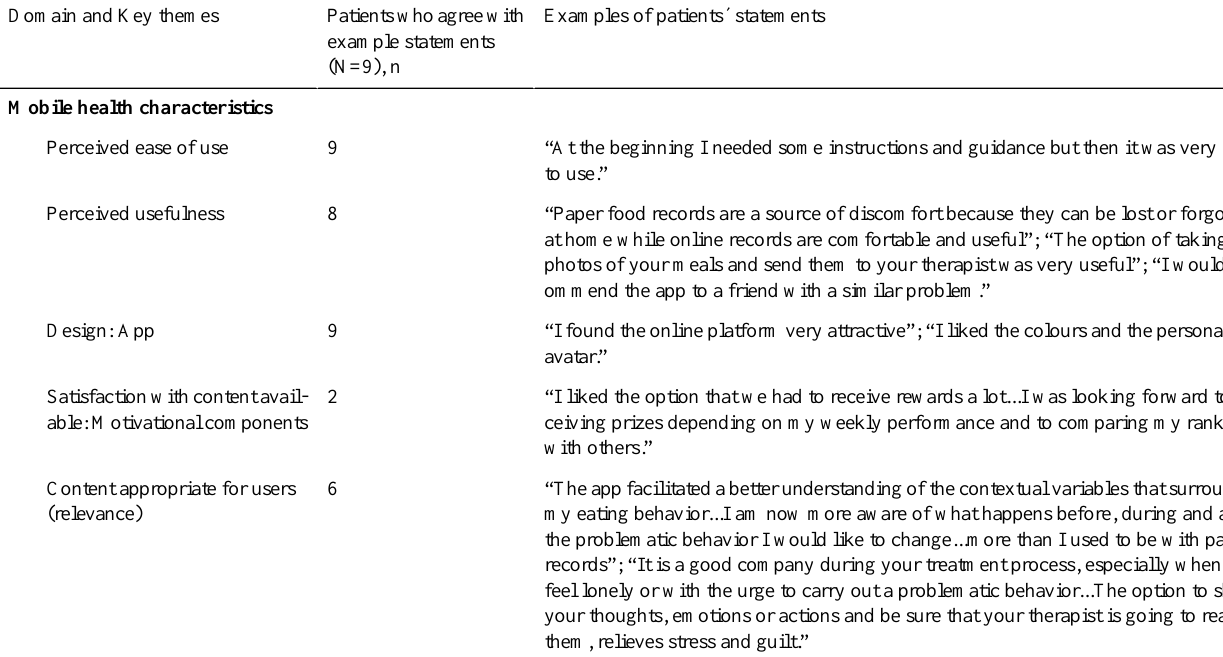
Table 5. Perceived advantages of the TCApp by